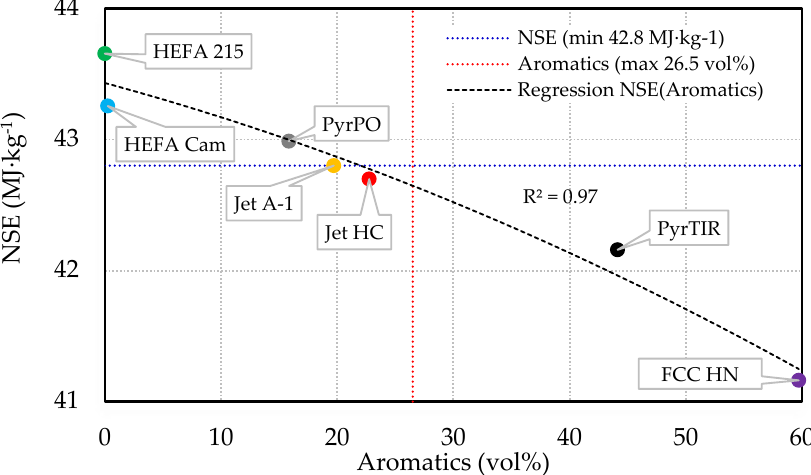
Figure 10. Relationship between measured net specific energy (MJ·kg −1 ) and aromatics of the samples studied.